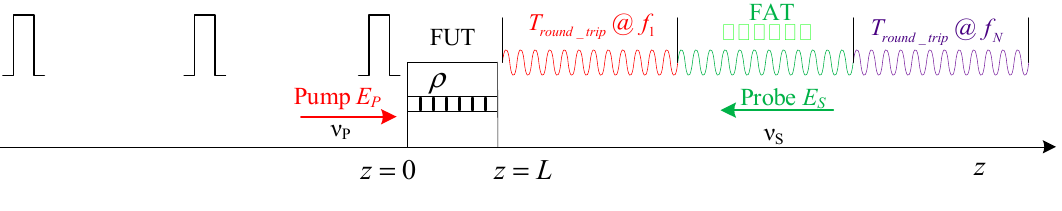
Figure 4. The OFA-based fast BOTDA scheme [34].